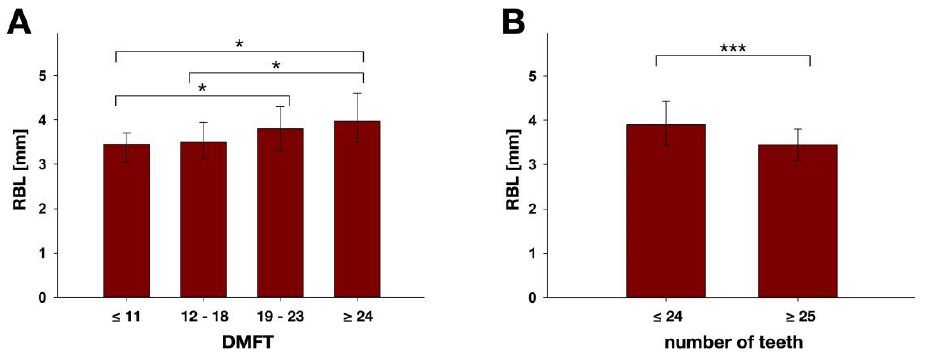
Figure 4. Results of RBL analysis according to ( A ) the different DMFT score groups ( ≤ 11, n = 23; 12–18, n = 57; 19–23, n = 67; ≥ 24, n = 16) and ( B ) number of teeth ( ≤ 24, n = 73; ≥ 25, n = 90). Results are depicted as medians, first and third quartiles and asterisks depict statistically significant differences between the groups. * marks significant differences with p ≤ 0.05; *** marks significant differences with p ≤ 0.001.